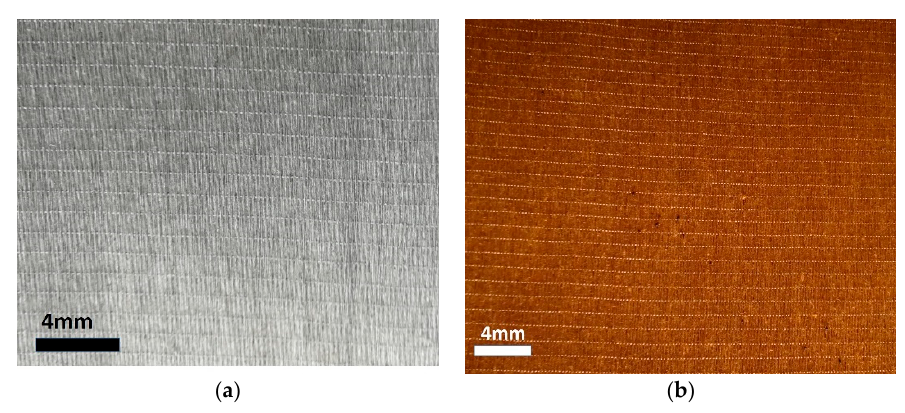
Figure 1. ( a ) Untreated flax fiber fabric; and ( b ) furfuryl alcohol (FA) treated flax fiber fabric.